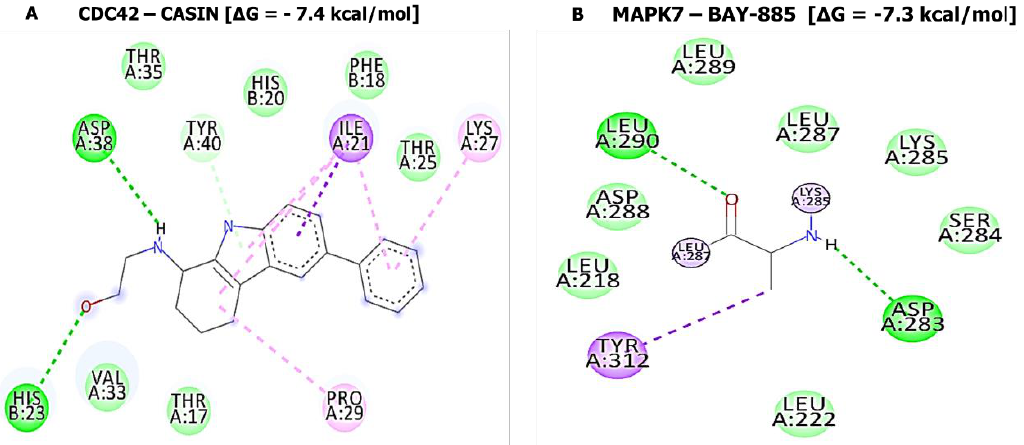
Figure 12. In silico docking results CDC42 and MAPK7 with standard inhibitors ( A ) interaction of CDC42 in complex with CASIN exhibited binding energy of ( − 7.4 kcal/mol). ( B ) MAPK7 in complex with BAY-885 displayed binding energy of ( − 7.3 kcal/mol) , in 2D representations. Table 2. Analytical summary table showing interactions of SJ10 with CCNB1/CDC42/MAPK7/ CD44 oncogenes.